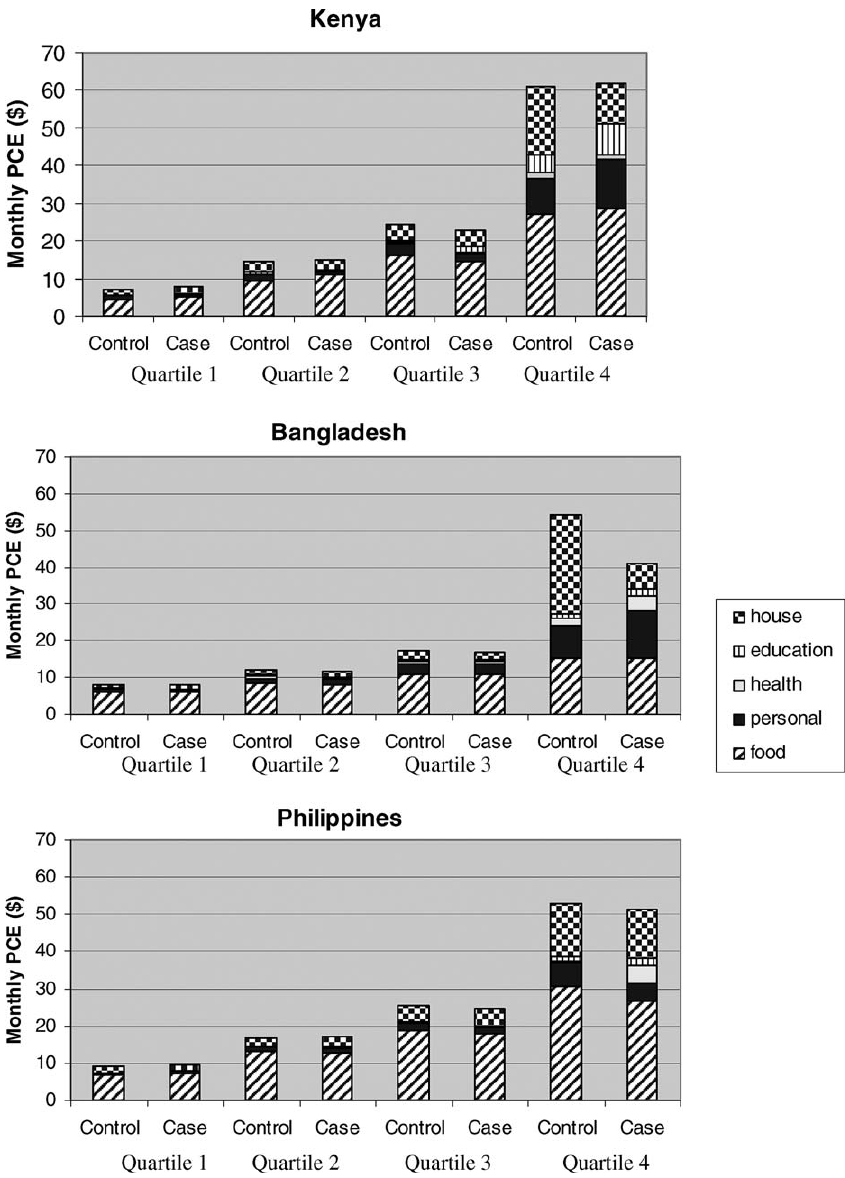
Figure 1. Per Capita Monthly Expenditure, by Quartile of Expenditure, for Cases and Controls in Kenya, Bangladesh, and the Philippines